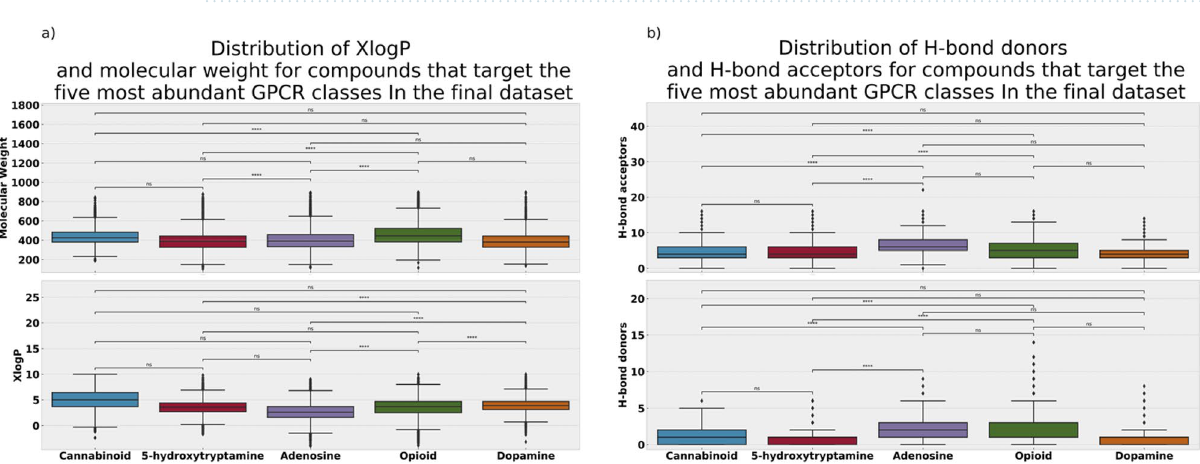
Figure 3. Two box-plots displaying the physicochemical properties distributions of the five most abundant GPCR targets represented within the selected subset of the GLASS database; ( a ) Molecular weight & XlogP, and ( b ) H-bond acceptors & H-bond donors. Statistical tests of significance were calculated using the statannot 0.2.3 python library, through the Mann–Whitney-Wilcoxin test, with Bonferroni correction: ns: 5.00e−02 < p ≤ 1.00e + 00. *: 1.00e−02 < p ≤ 5.00e−02. **: 1.00e−03 < p ≤ 1.00e−02. ***: 1.00e−04 < p ≤ 1.00e−03. ****: p ≤ 1.00e−04. The figure was generated with Python Matplotlib 3.2.1: https:// matpl otlib.